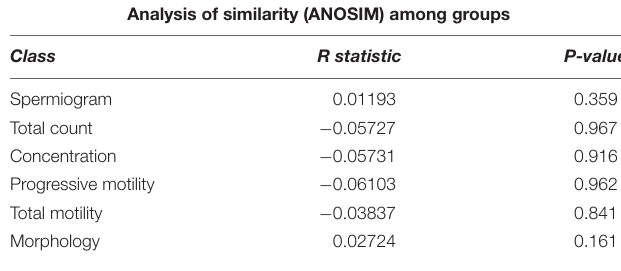
TABLE 2B | Summary of beta diversity